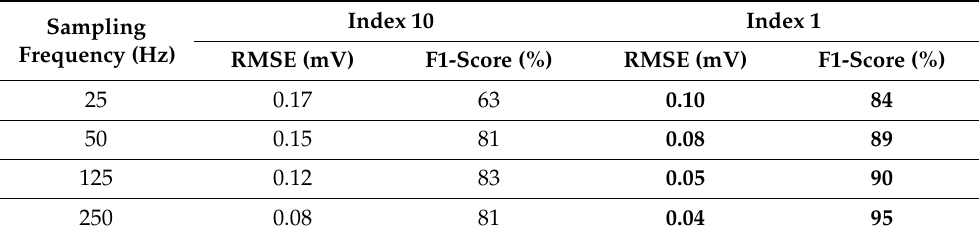
Table 4. Experimental result of the classi fi cation.